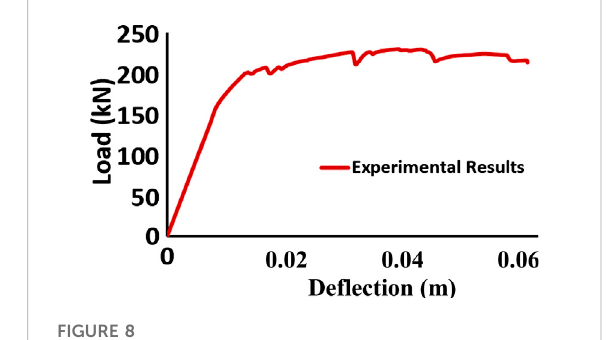
FIGURE 8 Crack and fl exure behaviour of RCB with 75% bottom ash.